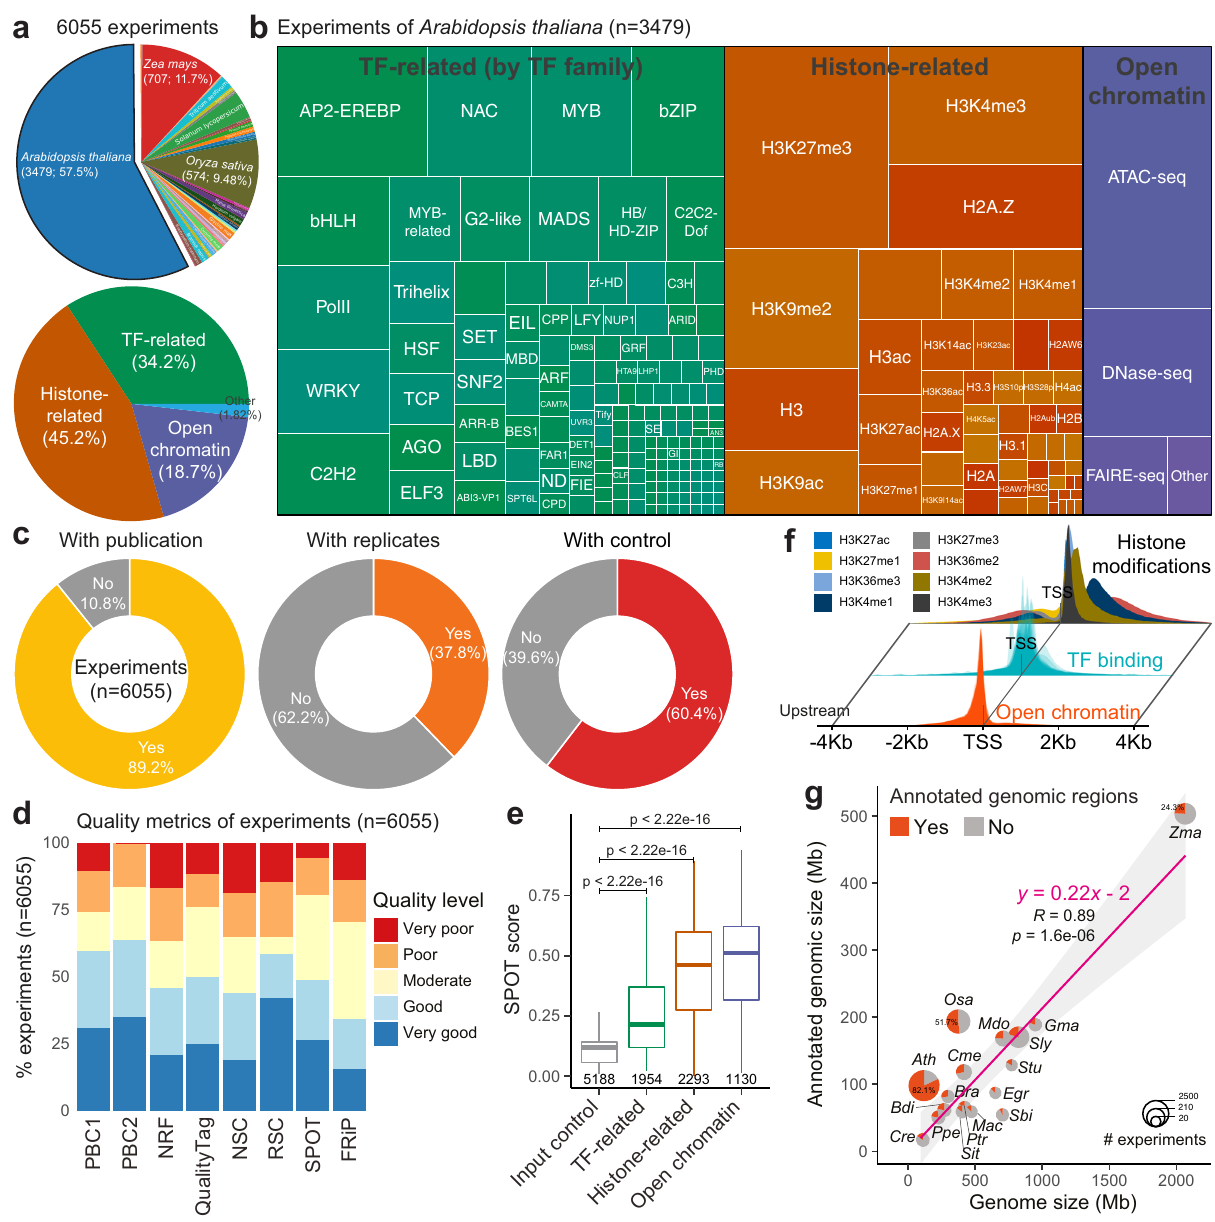
Fig. 2 Evaluation of plant regulome and epigenome data. a The annotated experiments by plant species (up) or experimental categories (bottom). b Treemap showing the classi fi cation of experiments in Arabidopsis thaliana according to transcription factor (TF) families, the types of histone modi fi cations or open chromatin experiments. c Donut charts showing different aspects of evaluation of the annotated experiments. d The bar chart showing the quality of experiments based on various quality metrics proposed by the ENCODE consortium 10 . e Comparison of SPOT scores among different experimental categories. Experiments of input DNA are used for control. The number of datasets in each category is indicated below the boxplot. Statistical signi fi cance of difference in terms of the SPOT score between the experiment group and control was calculated by the two-sided Mann – Whitney U test. Boxplot shows the median (horizontal line), second to third quartiles (box), and Tukey-style whiskers (beyond the box). f Distribution of peak summit around the transcription start site (TSS). g Annotated genomic regions versus the genome size. Pie charts show the percentage of genomes annotated by ChIP-seq data. Fitted line and standard errors with 95% con fi dence intervals are shown. Only genomes with >20 experiments are shown. Full names of genomes can be found in Supplementary Data 11. SPOT: signal portion of tags; FRiP fraction of reads in peaks; NSC normalized strand cross- correlation coef fi cient. RSC relative Strand cross-correlation coef fi cient, NRF non-redundant fraction, PBC1/2 PCR bottlenecking coef fi cients 1/2. Source data are provided as a Source Data fi